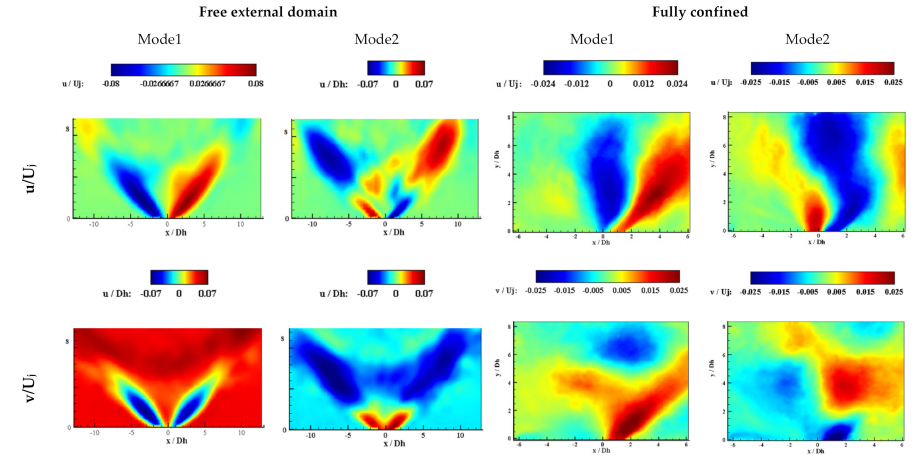
Figure 16. Spatial patterns of the POD modes for the both free and fully external domains at Re = 10,730.